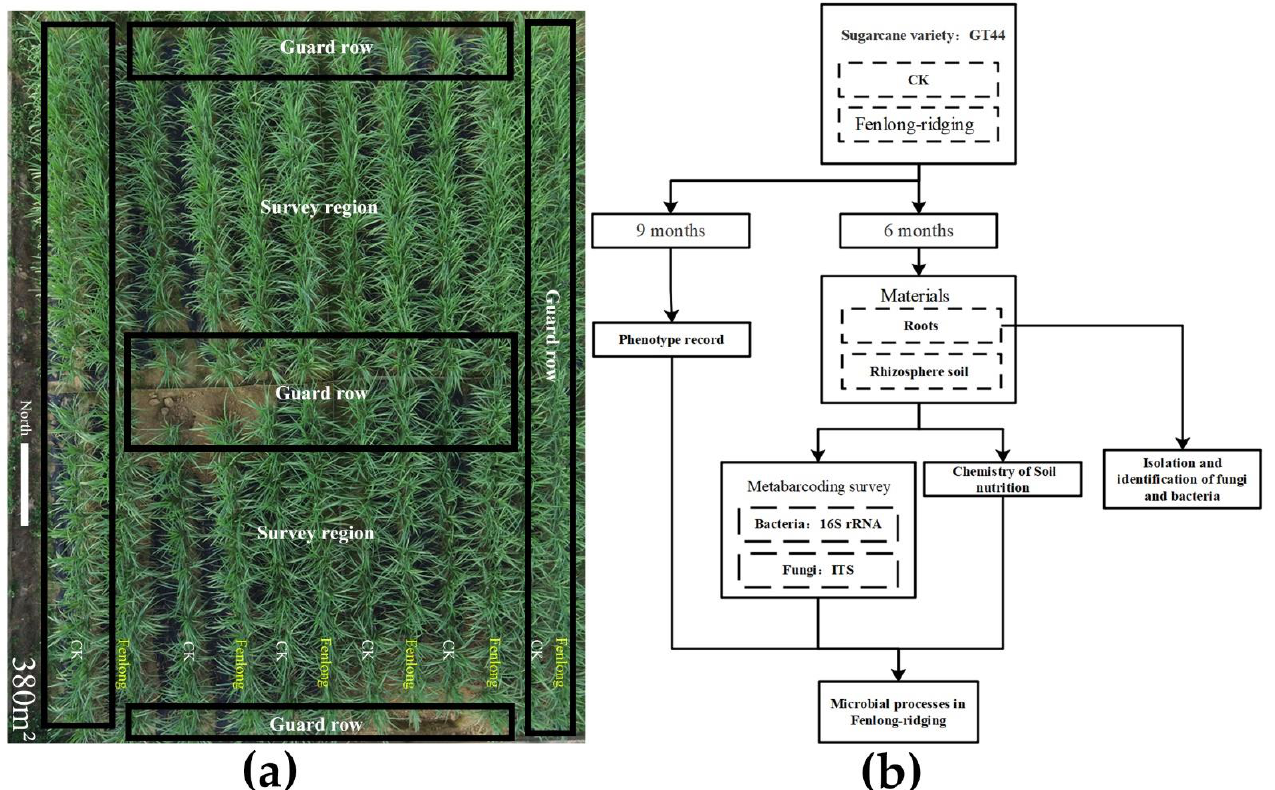
Figure 1. Design of the plots in field experiment ( a ) and the procedure of the sampling and analysis ( b ). “Fenlong” indicates Fenlong - ridging while “CK” is conventional tillage. At the sixth month af- ter planting, the samples of sugarcane roots and rhizosphere soil were collected for metabarcoding sequencing and testing of the soil chemistry properties. Meanwhile, artificial isolation of endophytic bacteria and fungi from roots were conducted. At the ninth month, the sugarcane yield traits were investigated. Based on the data obtained from above processes, the microbial process of Fenlong- ridging in sugarcane was evaluated and analyzed.